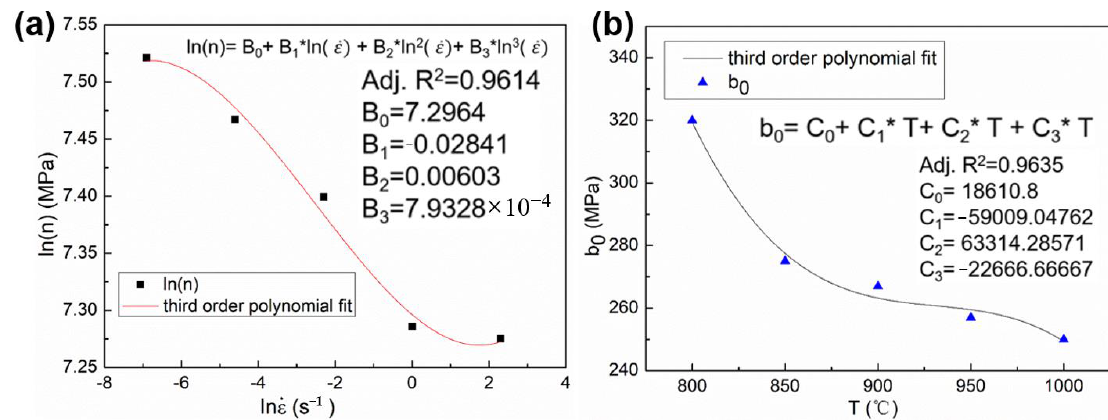
Materials 2023 , 16 , 1927 Figure 10. The fitted curves of the ( a ) ln(n) and ( b ) b 0 . Figure 10. The fitted curves of the ( a ) ln(n) and ( b ) b 0 .